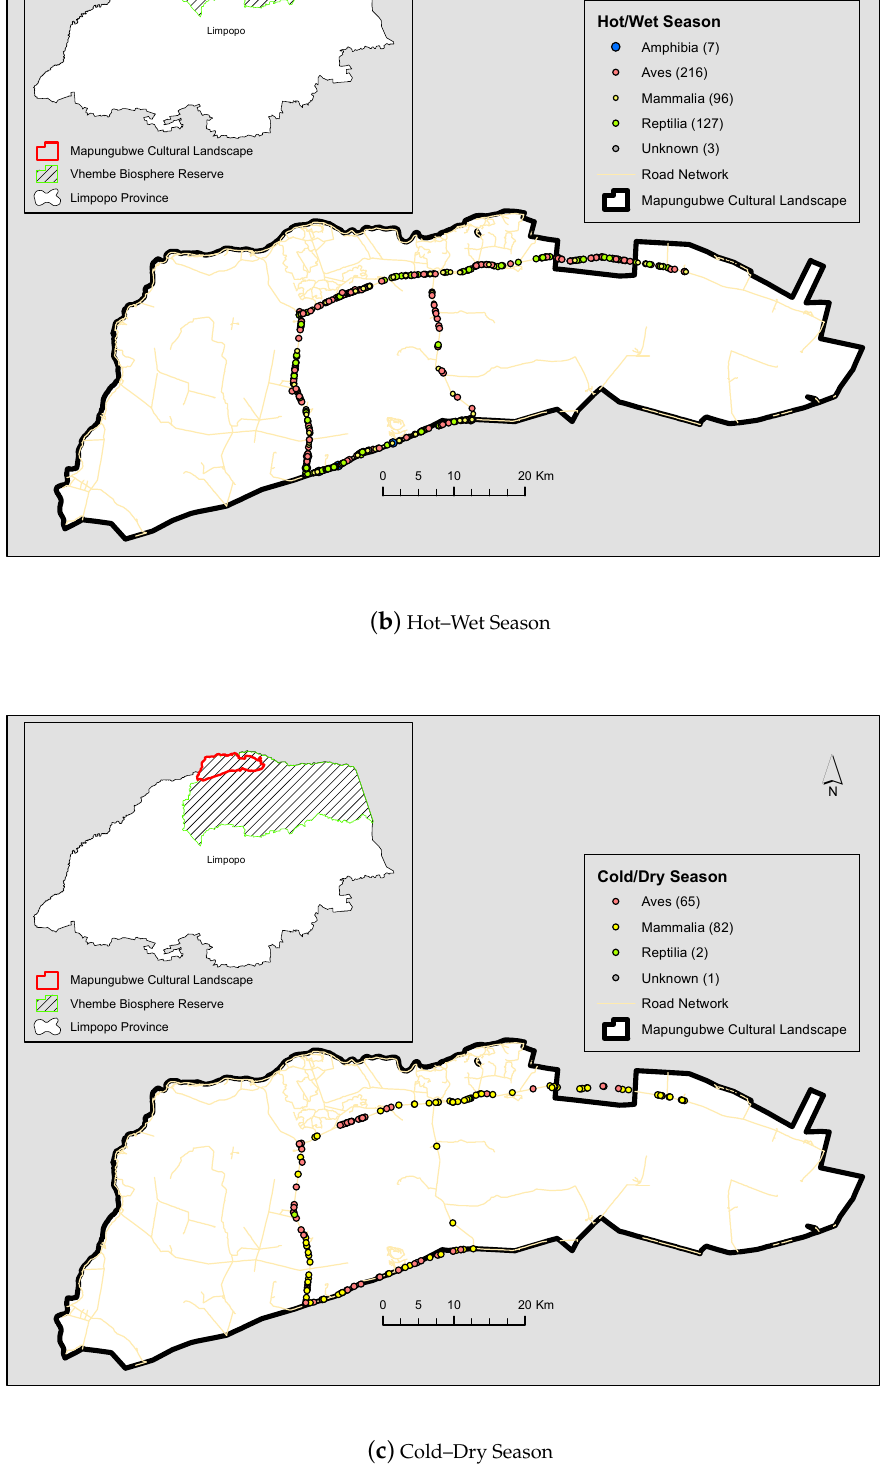
Figure 1. The dataset is composed of the three ecological seasons of South Africa, which are hot–dry ( a ), hot–wet ( b ), cold–dry ( c